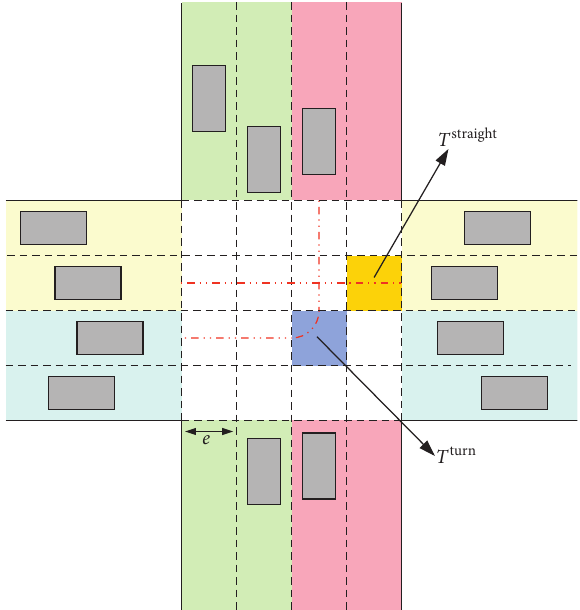
Figure 4: The two types of paths within the IR and service times of cells that correspond to straight and turning segments of paths, respectively. When a vehicle makes a turn, it maintains the same lane in its exit road with its entry